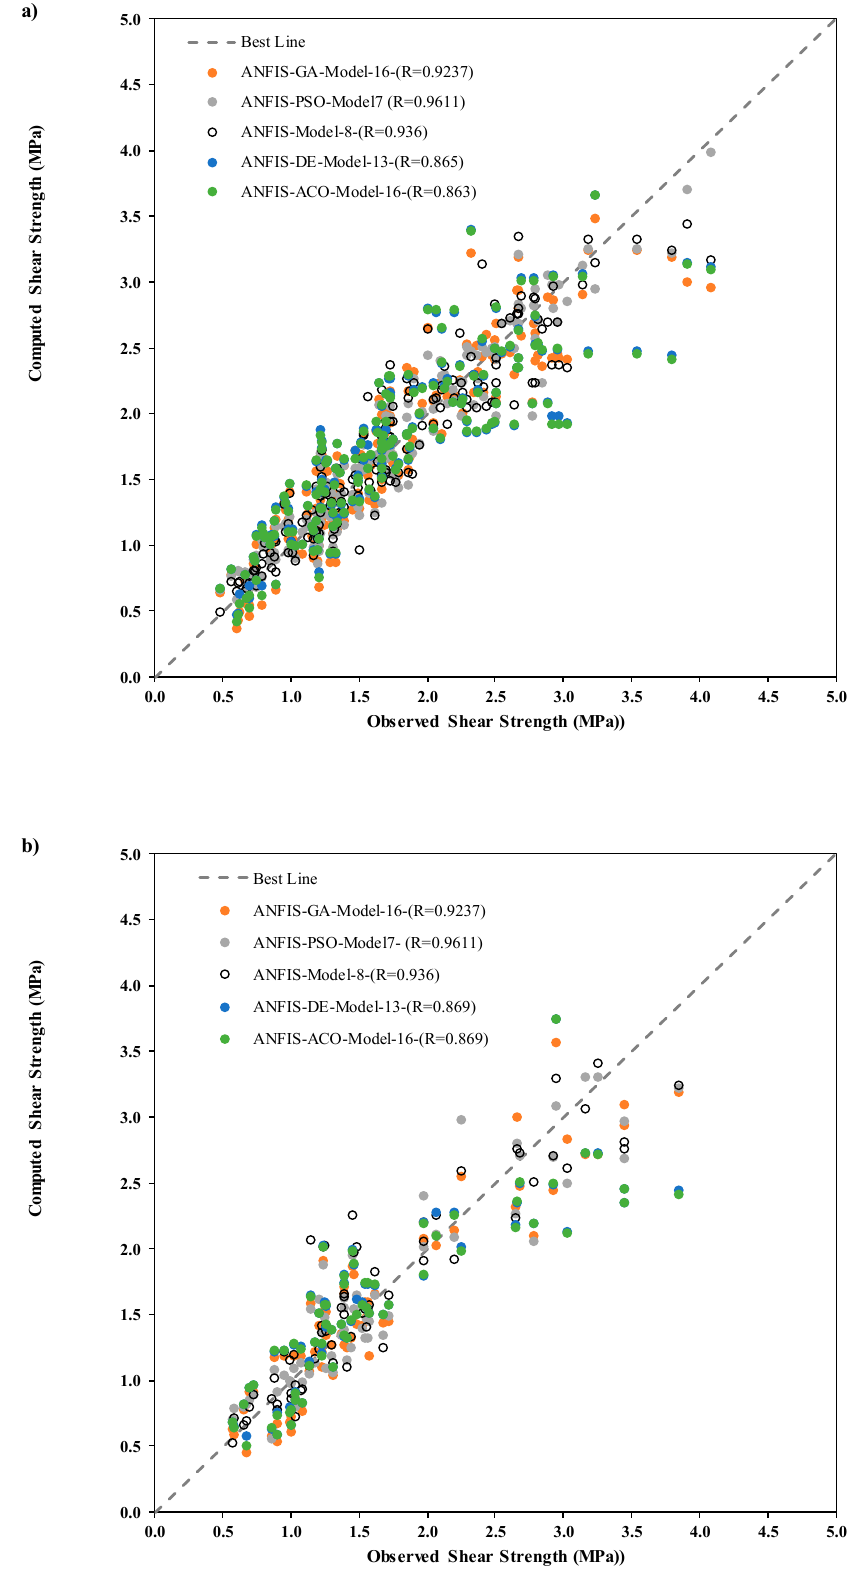
Figure 4. Scatter plots presentation between the observed and predicted values of computed shear strength for the best input combination and models: ( a ) Training stage and ( b ) Testing